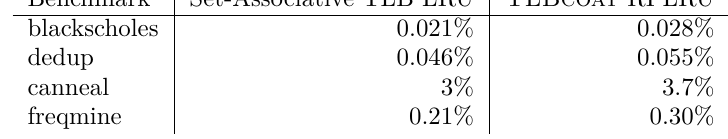
Table 3: PARSEC benchmark results for system under load comparing regular set- associative TLBs to TLBcoat by their respective miss ratio. The system constantly executes the blackscholes benchmark in the background to generate